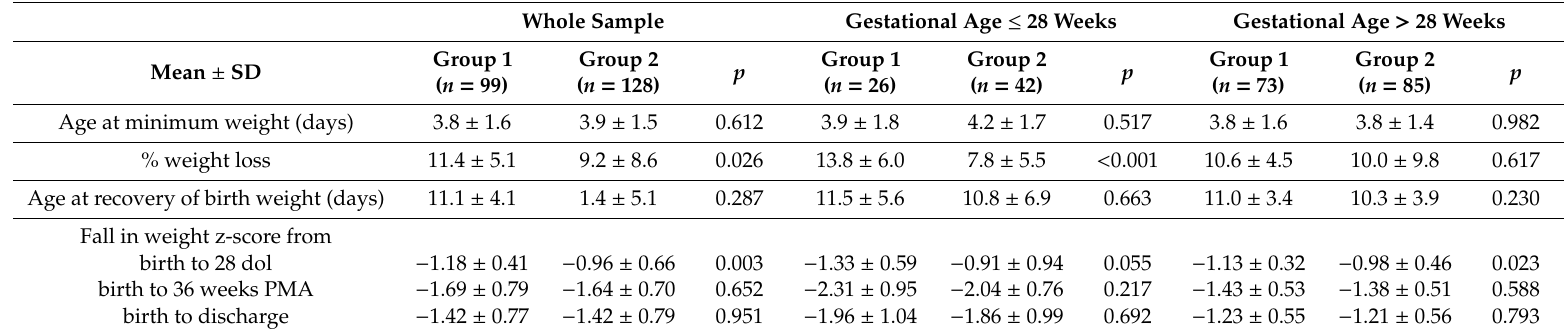
Table 2. Growth parameters of patients in Group 1 and